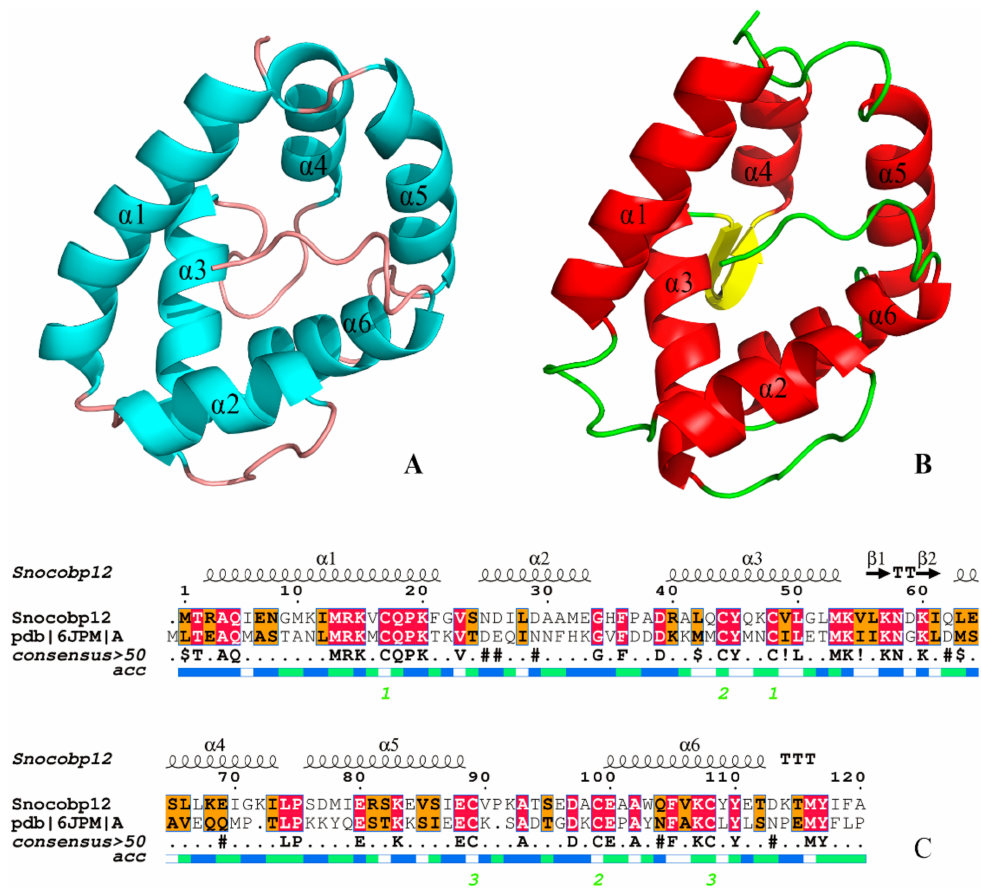
Figure 1. The 3D structure of SnocOBP12. ( A ) Structural modeling of SnocOBP12; ( B ) the crystal structure of CaplOBP 4 in Chrysopa pallens ; ( C ) sequence alignment of SnocOBP12 and